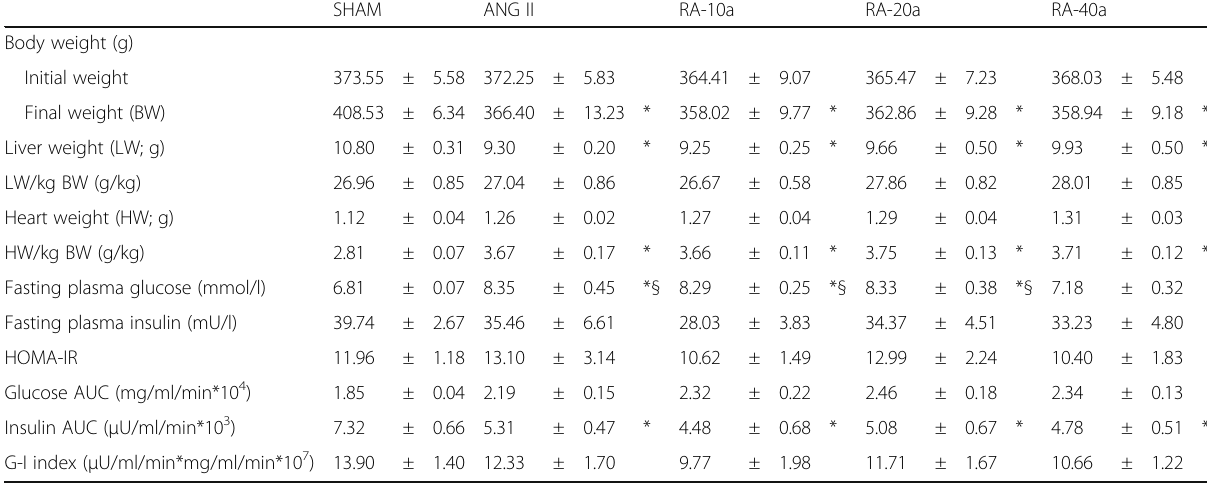
Table 1 Animal characteristics and glycemic control in SHAM and ANG II-treated rats and in ANG II-treated rats following acute administration of RA at 10, 20, or 40 mg/kg